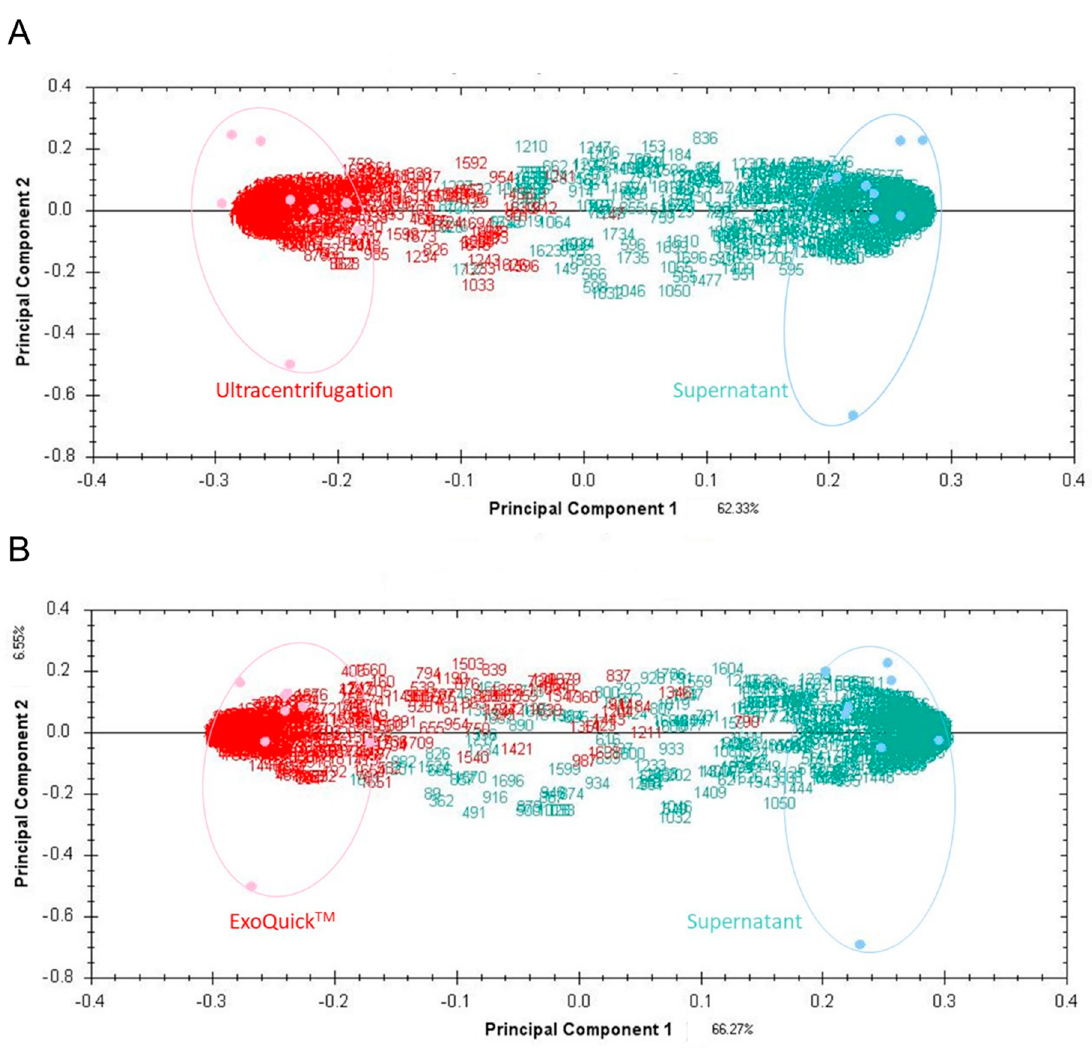
Figure 1. Unsupervised PCA plots based on all 936 total protein spots detected between EV pellets and corresponding serum supernatants isolated by ( A ) ultracentrifugation or ( B ) ExoQuick ™ . Red, proteins with higher expression in Ultracentrifugation / ExoQuick™; Green, proteins with higher expression in the supernatant.